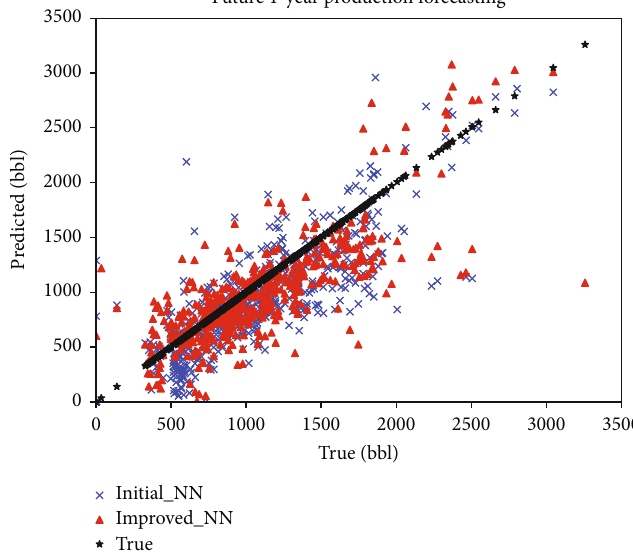
Figure 12: Comparison of peak oil rate prediction of the DNN